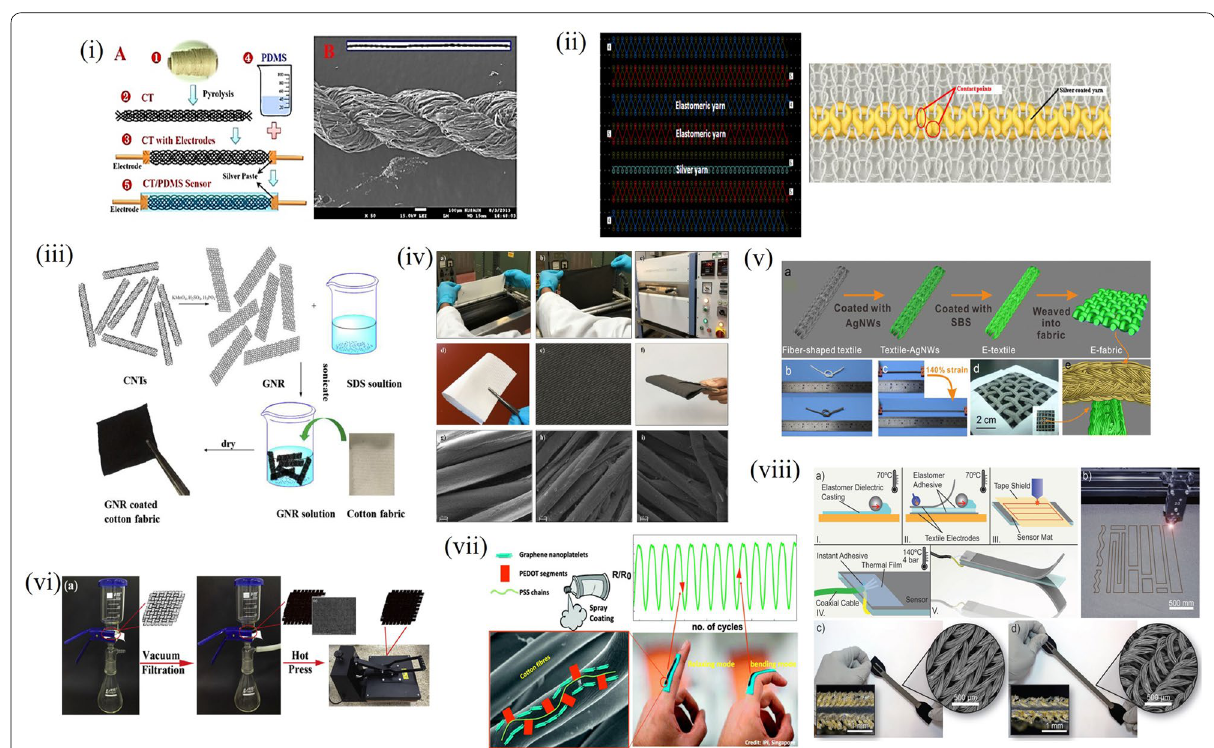
Fig. 7 Textile based sensing platforms (i) Pyrolysis assisted CNT-PDMS sensor (Reproduced by permission from [125]. Copyright 2017, Nature ) (ii) Elastomer yarns supporting silver coated yarn giving stitched textile like sensor (Reproduced by permission from [128] Copyright 2013, MDPI ) (iii) Cotton fabric made conductive by dip-dry in CNT-Graphene solution (Reproduced by permission from [132] Copyright 2018, Elsevier ) (iv) Large scale fabric sensor fabrication with padding and rolling and uniform heating for flexible sensor (Reproduced by permission from [129] Copyright 2017, American Chemical Society ) (v) Silver NW coated fibre yarn coated with SBS elastomer for flexible and stretchable sensor (Reproduced by permission from [134] Copyright 2018, Springer ) (vi) Vacuum infiltrated fabric with graphene oxide (GO) and reduced to rGO by hot press giving area scalable and uniform heating (Reproduced by permission from [131] Copyright 2017, Elsevier ) (vii) Spray coated PEDOT on fabric (Reproduced by